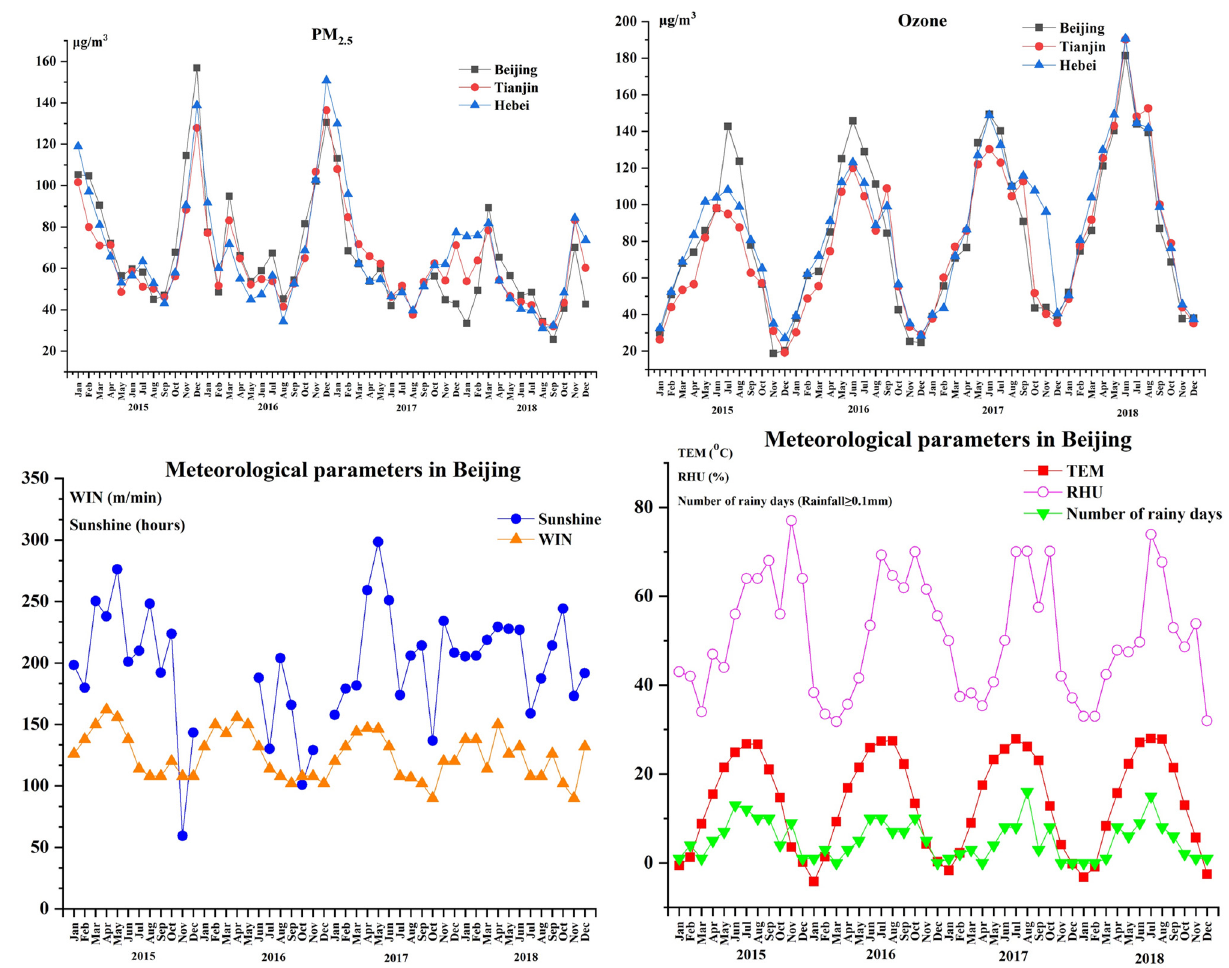
Figure 4. Variation in monthly average concentrations of PM 2.5 and ozone in the Beijing–Tianjin– Hebei region and meteorological parameters in Beijing City from 2015 to 2018. Sunshine, sunshine hours; WIN, wind speed (m/min); TEM, ambient temperature (°C); RHU, relative humidity (%).